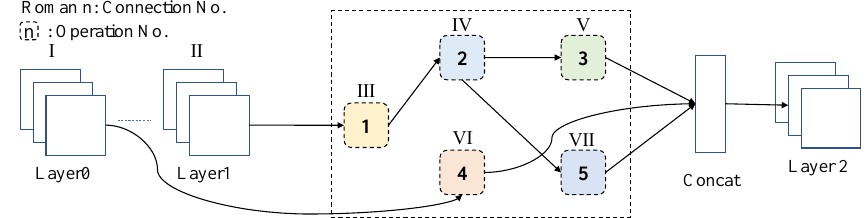
Figure 2. Search operations and